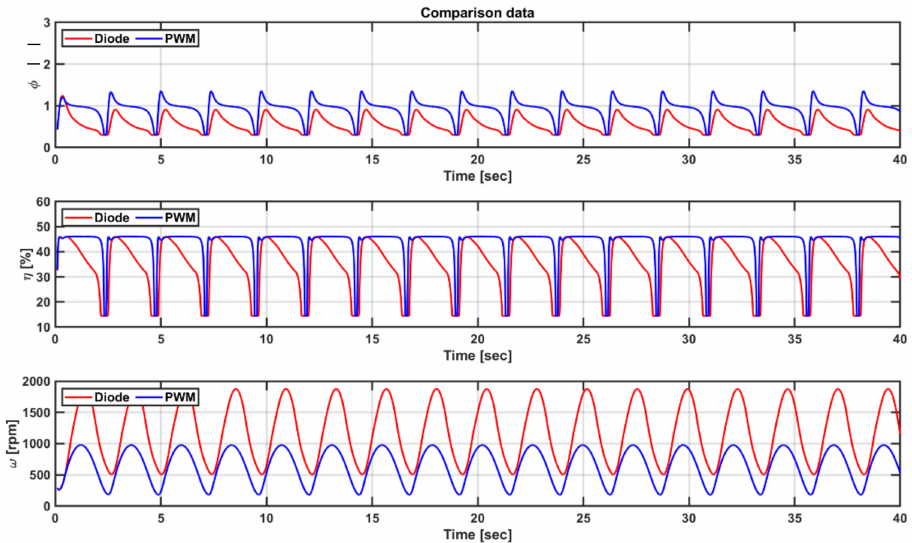
Figure 19. Turbine performance comparison using PTO system in integrated simulation under high regular wave conditions ( v t = 0~35 m / s and T = 4.75